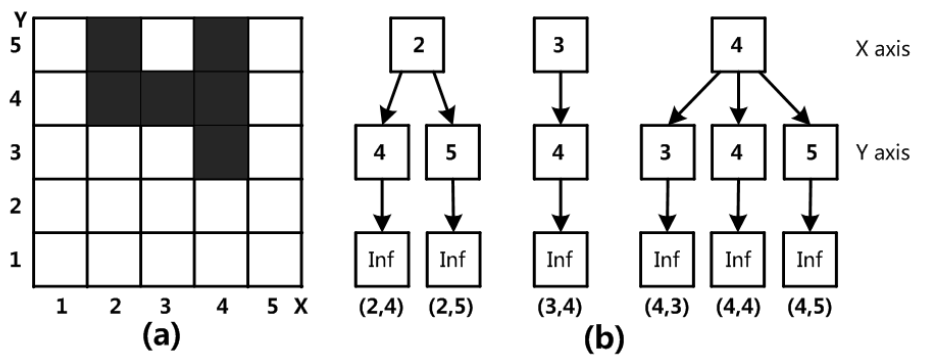
Figure 1. Schematic diagram of SP-Tree structure in 2D data space. ( a ) Two-dimensional Grid Struc- ture with Indexable Grids; ( b ) SP-Tree Index Structure with Leaf Nodes Containing Indexed Grid Data.